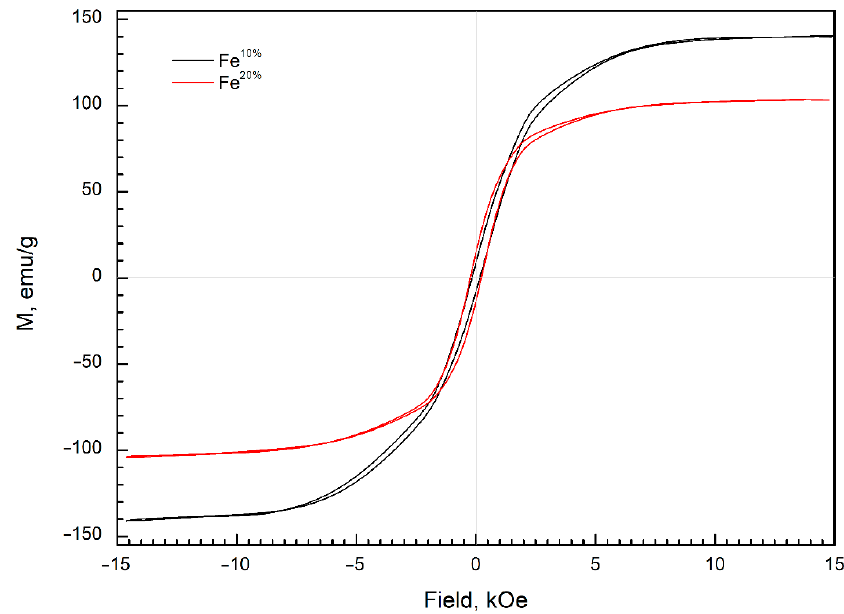
Figure 5. Hysteresis loops, measured from composites based on paraffin wax and filled with Fe 10% and Fe 20% powders.